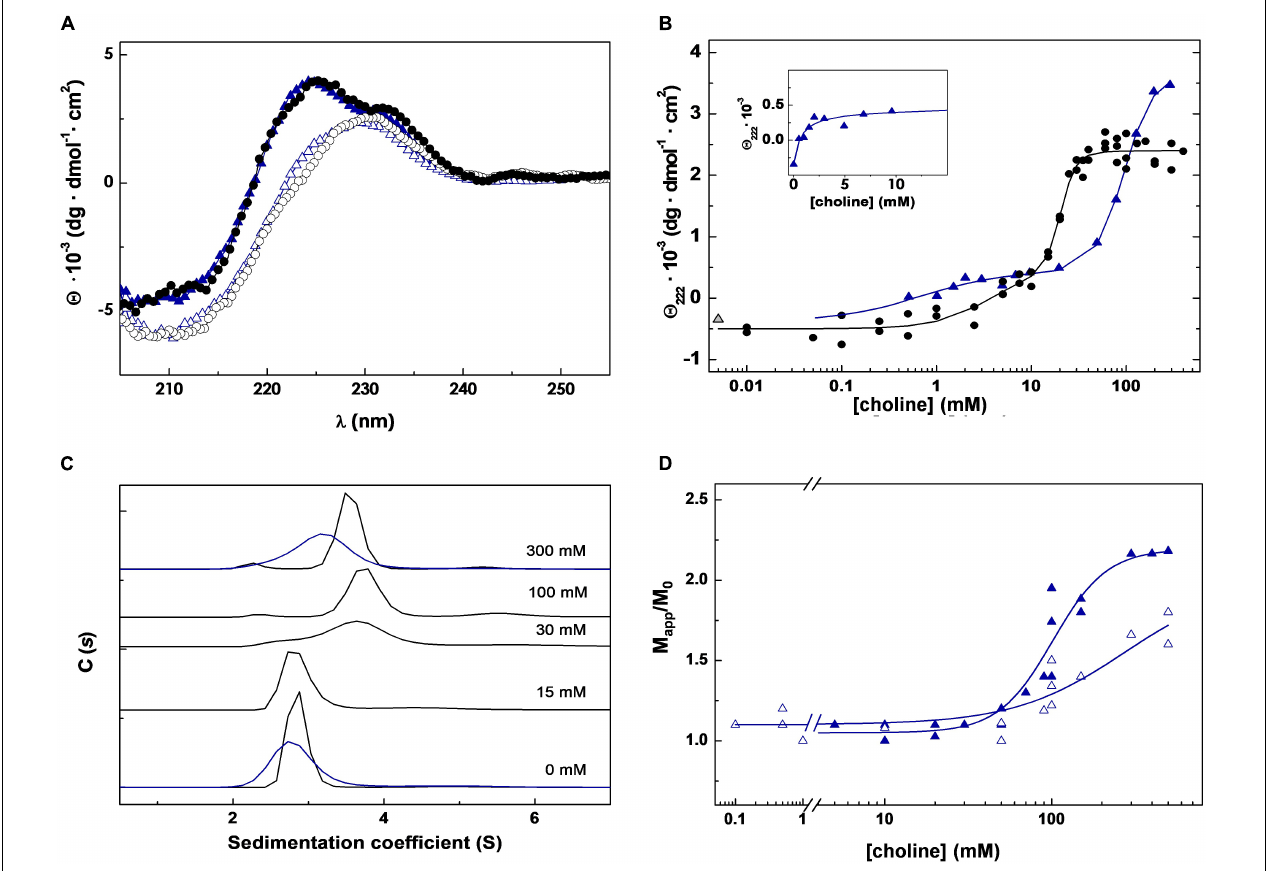
FIGURE 2 | Choline binding to Skl NAM-amidase. (A) Far-UV CD spectra of Skl WT (black circles) and the Y264H mutant (blue triangles) in the absence and presence of 300 mM choline (open and solid symbols, respectively). (B) CD choline titration into Skl WT (circles) and Y264H mutant (triangles) monitored by measuring the ellipticity variation at 222 nm as a function of ligand concentration. Solid lines are the theoretical fit of experimental data with the Hill equation extended to two sets of sites. The first phase of the Y264H titration curve is shown in the inset. (C) Monomer-dimer distribution of Skl WT (black lines) and Y264H mutant (blue lines) at choline concentrations indicated in panel labels, determined by sedimentation velocity under conditions of titration experiments. C(s) represents the sedimentation coefficient distribution. (D) Dependence of the relative molecular mass (Mapp /M0) of Skl Y264H mutant with choline concentration at pH 6.5 and 8.0 (open and full symbols, respectively). Mapp is the average molecular mass determined by equilibrium sedimentation and M 0 the monomer molecular mass. Data were acquired at 20 ◦ C in PB (pH 6.5), except for measurements at pH 8.0 (D) , performed in 50 mM Tris–HCl